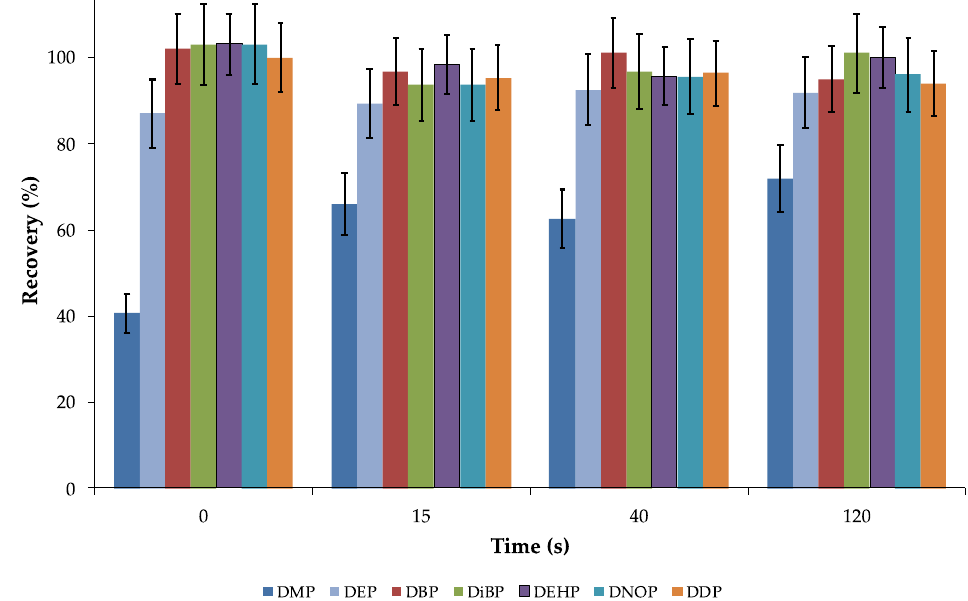
Figure 1. PAE recovery (%) in relation to the pick times from the vending machine and at different temperatures (i.e., pick up time 0 s, temperature 61 °C; 15 s, 59 °C; 40 s, 53 °C; 120 s, 35 °C). The bars represent the standard deviation of each measure. For PAE acronyms: see Table 1.